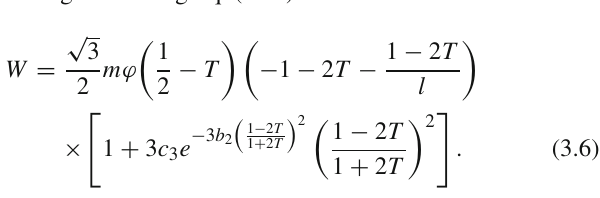
Fig. 1 The effective potential (solid line) for the superpotential in Eq. (3.2) with the choice of parameters λ/μ = 1 / 3, c 1 = 1 . 9, c 2 = − 0 . 73 and b 1 = 3 . 9615. The dashed like corresponds to the Starobinsky